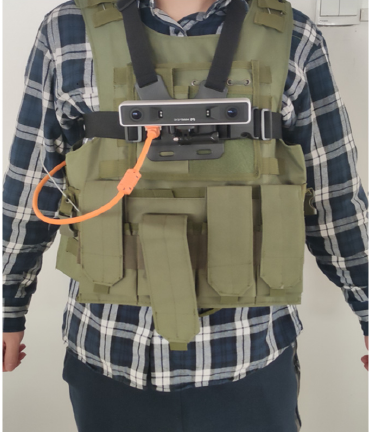
Figure 9. Testers’ experimental wear chart.